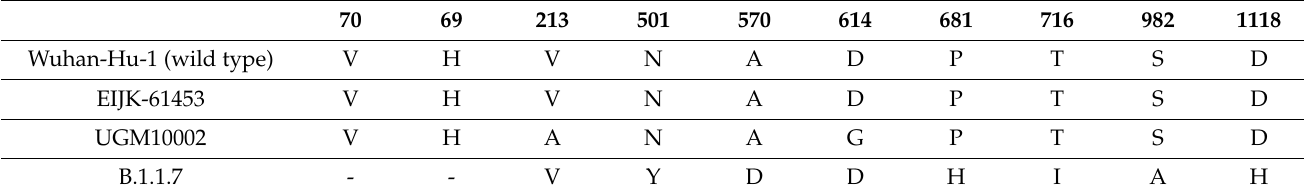
Table 2. The list of amino acid mutations against the Wuhan-Hu-1 ((NC_045512.2:21563-25384).